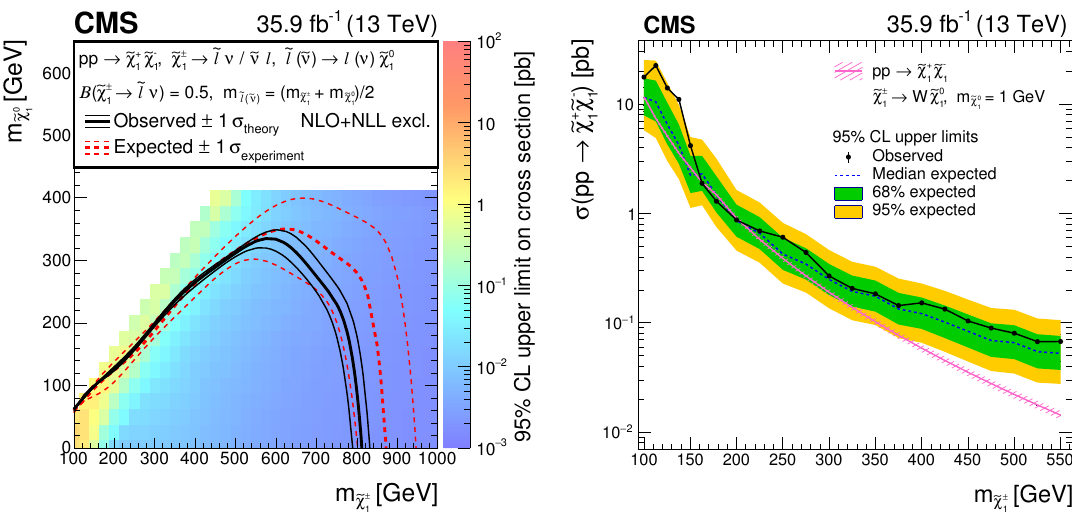
! (cid:31) (cid:6) ‘(cid:23) ( ‘ (cid:23) ) ! 1 e e e